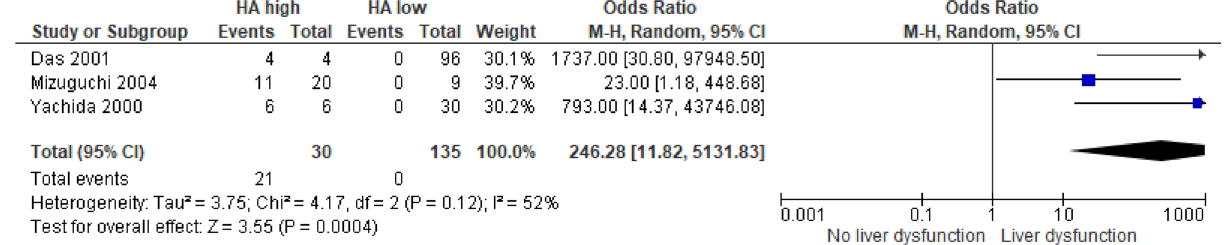
Figure 4. Forrest plot of studies examining postoperative serum HA levels and liver dysfunction.